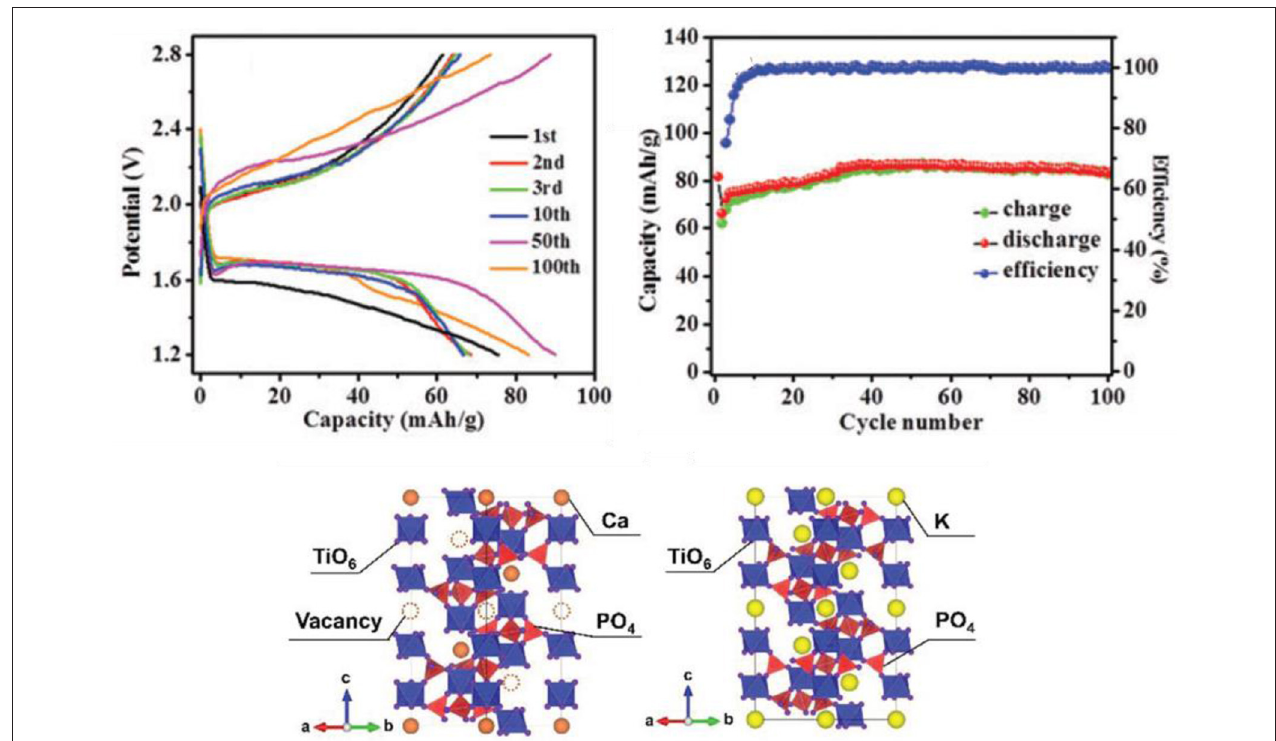
FIGURE 5 | On top, electrochemical performance of C-coated KTi 2 (PO 4 ) 3 ; below, crystallographic structure of Ca 0.5 Ti 2 (PO 4 ) 3 showing the cationic vacancies which promotes the potassium ion diffusion. Reproduced and adapted from Han et al. (2016a) with permission from the Royal Society of Chemistry, and with permission from Zhang Z. et al. (2018). Copyright (2018) WILEY-VCH Verlag GmbH & Co. KGaA,